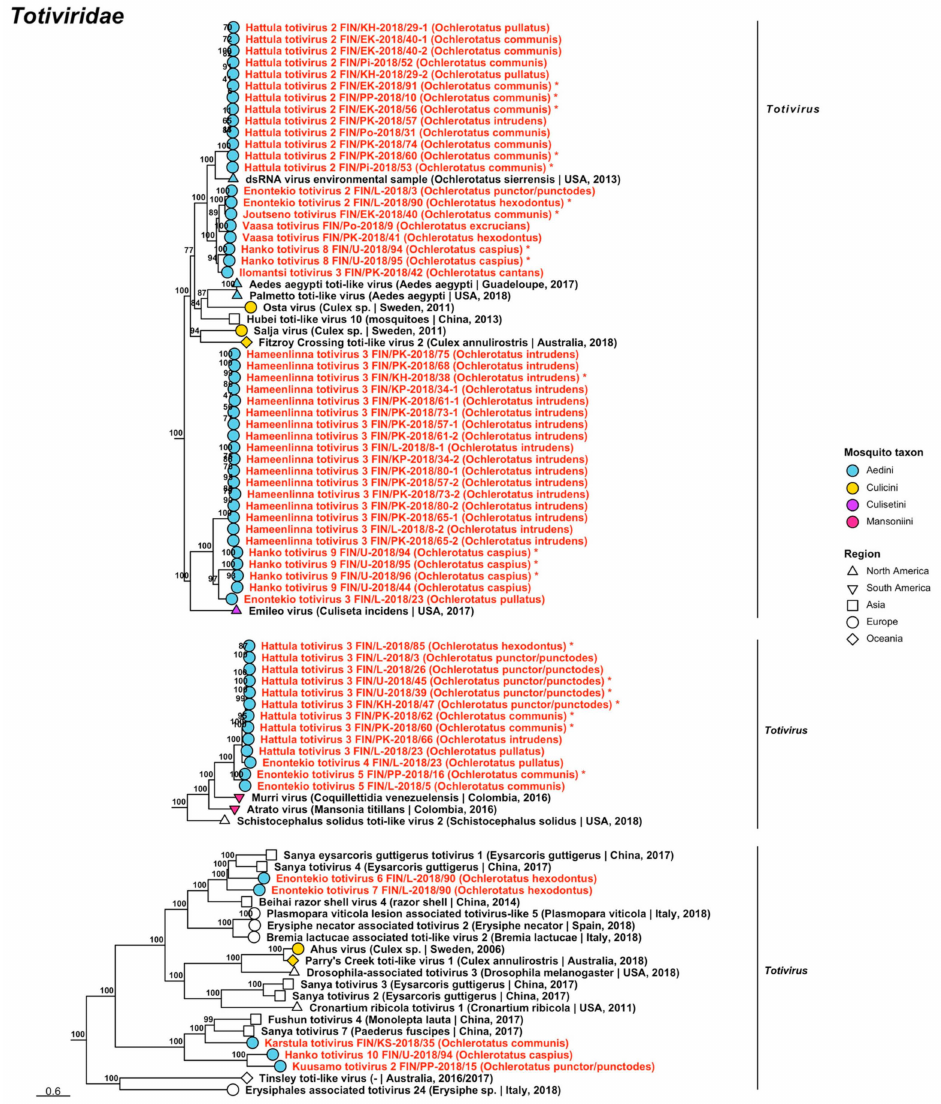
Figure 24. Maximum likelihood subtrees of Totiviridae . Tentative novel viruses are displayed in red and the mosquito species from which they were derived are in parentheses. Sequences from GenBank are black and display the following information after the virus or species name: “(sampled organ- ism(s)|collection country, collection year)”. Tip colours represent the tribe of mosquito from which viruses were obtained. Tip shape represents the continent or region from which the specimens were collected. Trees were constructed from amino acid sequences of virus polymerases >1000 nt, aligned with MAFFT and computed with IQ-TREE2 using ModelFinder and 1000 bootstraps. Asterisks denote that the complete genome was